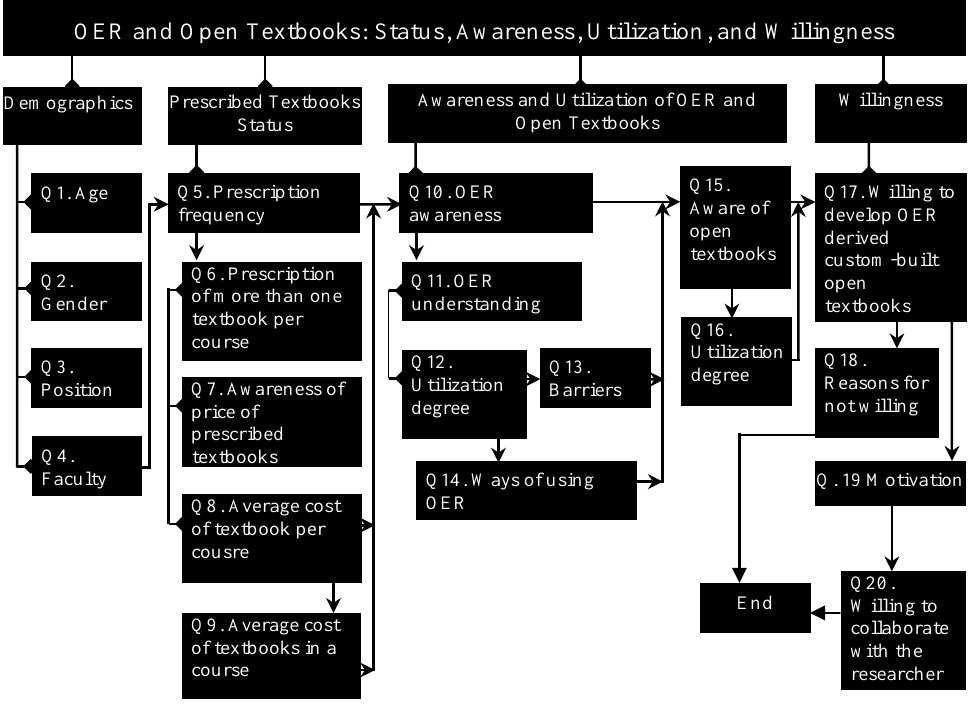
Figure 1 . Survey questionnaire